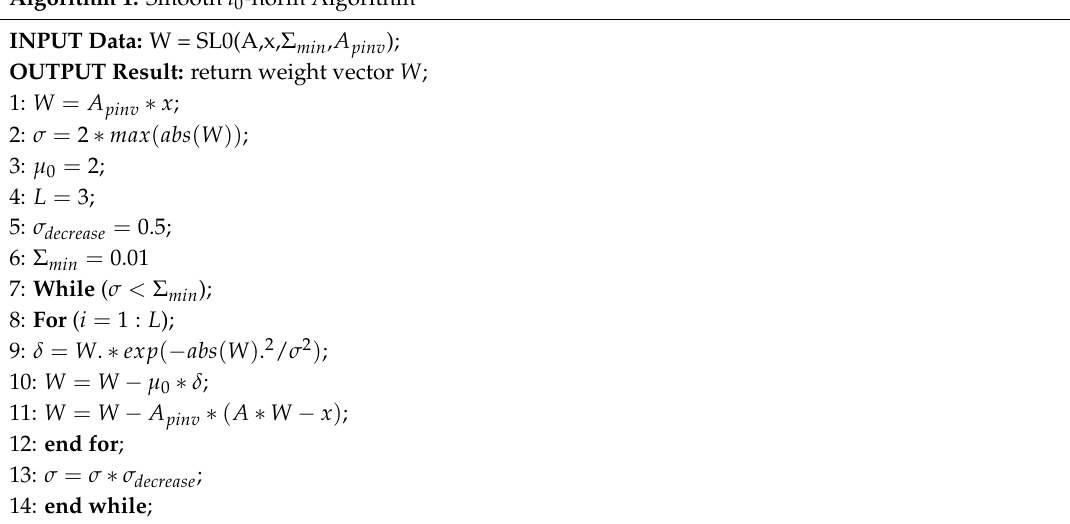
Algorithm 1. Smooth l 0 -norm Algorithm